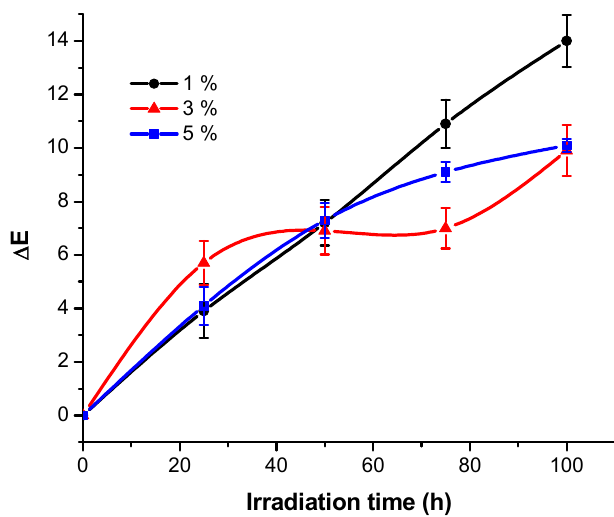
Figure 4. Total colour changes generated by exposure RB_204 samples under UV light.